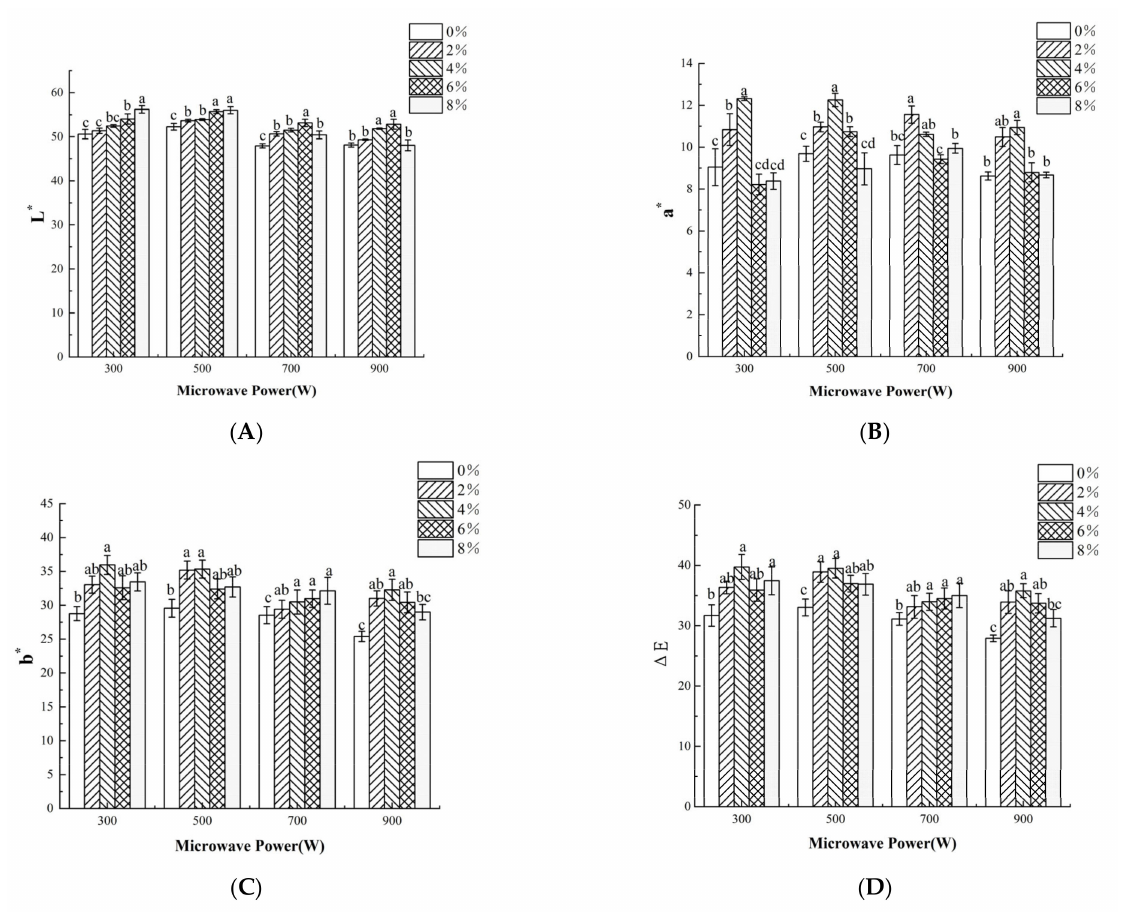
Figure 3. Effects of salt concentration and MW power on color parameters of dried shrimps by MW drying. ( A ) L *; ( B ) a *; ( C ) b *; ( D ) ∆ E . Different letter indicates statistically significant difference at p < 0.05 according to the Duncan test.